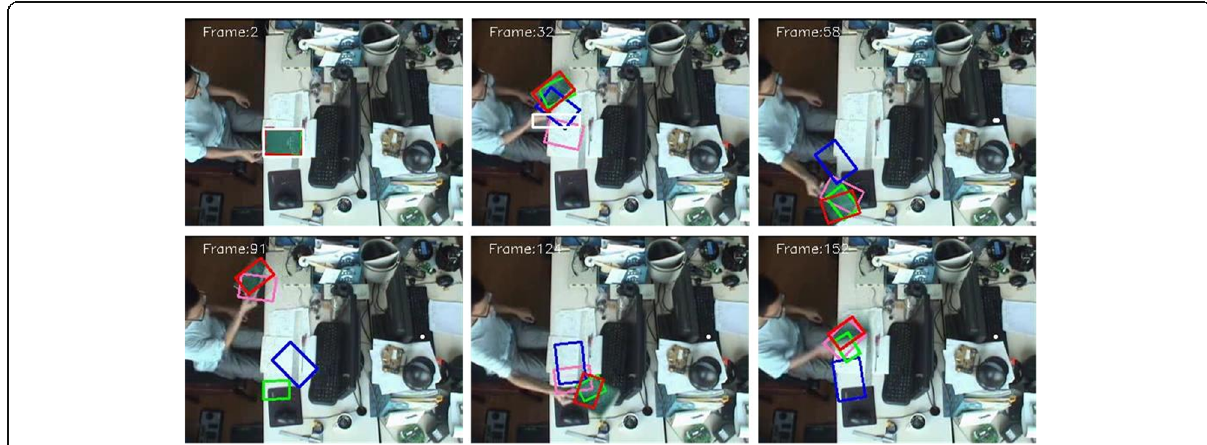
Fig. 13 The tracking results for the video “ book ” using CAM-Shift (white), PF (blue), VAPF (green), M-PF (pink), and the proposed tracker (red). Par- ticle number N =